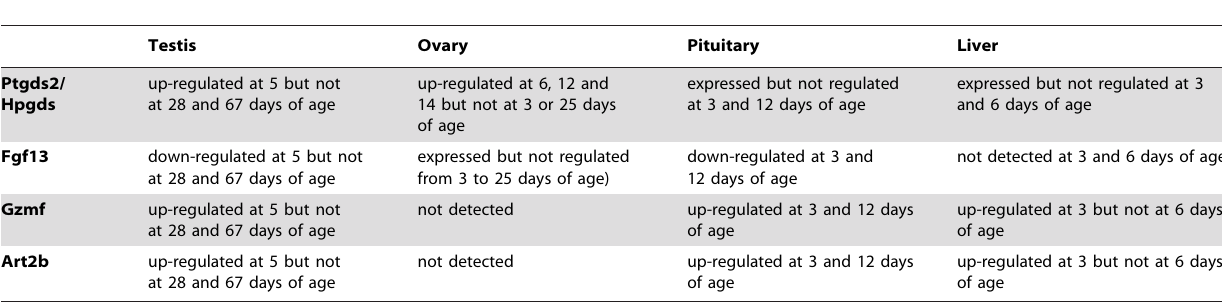
Table 6. Summary of the effects on Art2b, Fgf13, Gzmf and Ptgds2/Hpgds following TCDD exposure.